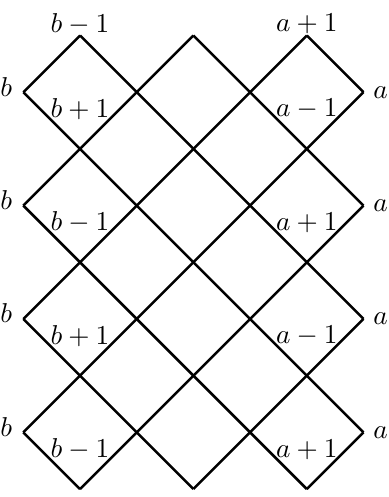
Figure 22 . Alternating boundary conditions on both sides. We will write this boundary condition b (cid:6) ; : : : ; (cid:7) a and refer to it as \anti-correlated" boundary